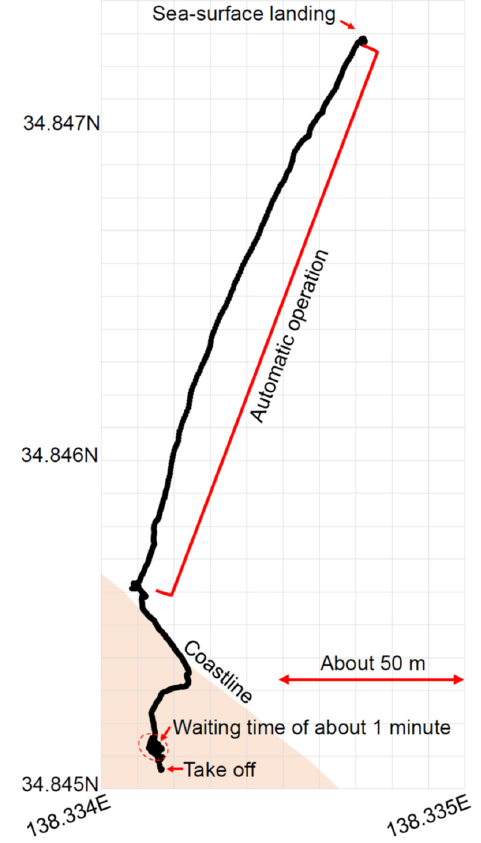
Figure 10. Precise UAV position from takeoff to sea-surface landing determined using dual- frequency